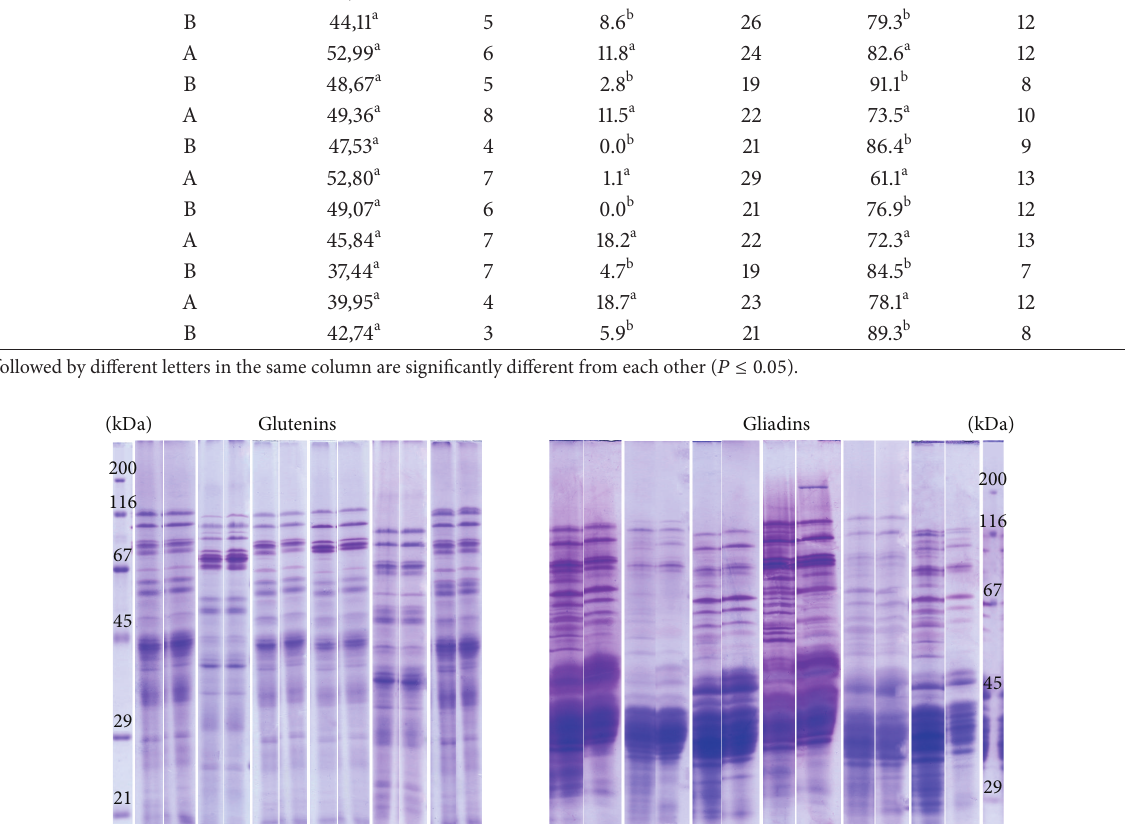
Scanning electron micrographs of endosperm